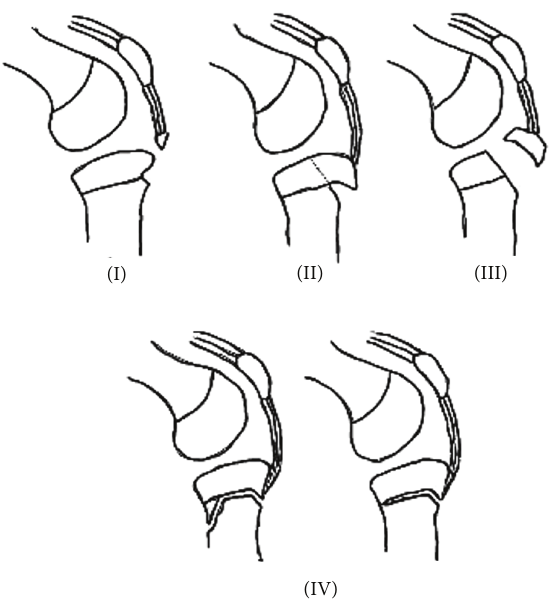
Figure 2: The modified Watson-Jones classification of tibial epi- physeal fractures. The original classification was for tibial tubercle fractures and included the first three types. Ryu and Debenham proposed type IV injury as an addition to the